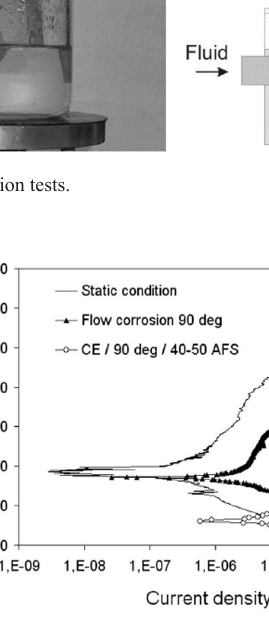
Figure 4. Potentiodynamic curves obtained for AISI 304L steel in static condition and during liquid impingement and erosion-corrosion tests with 90º, 6.5 m/s, and 3.5%